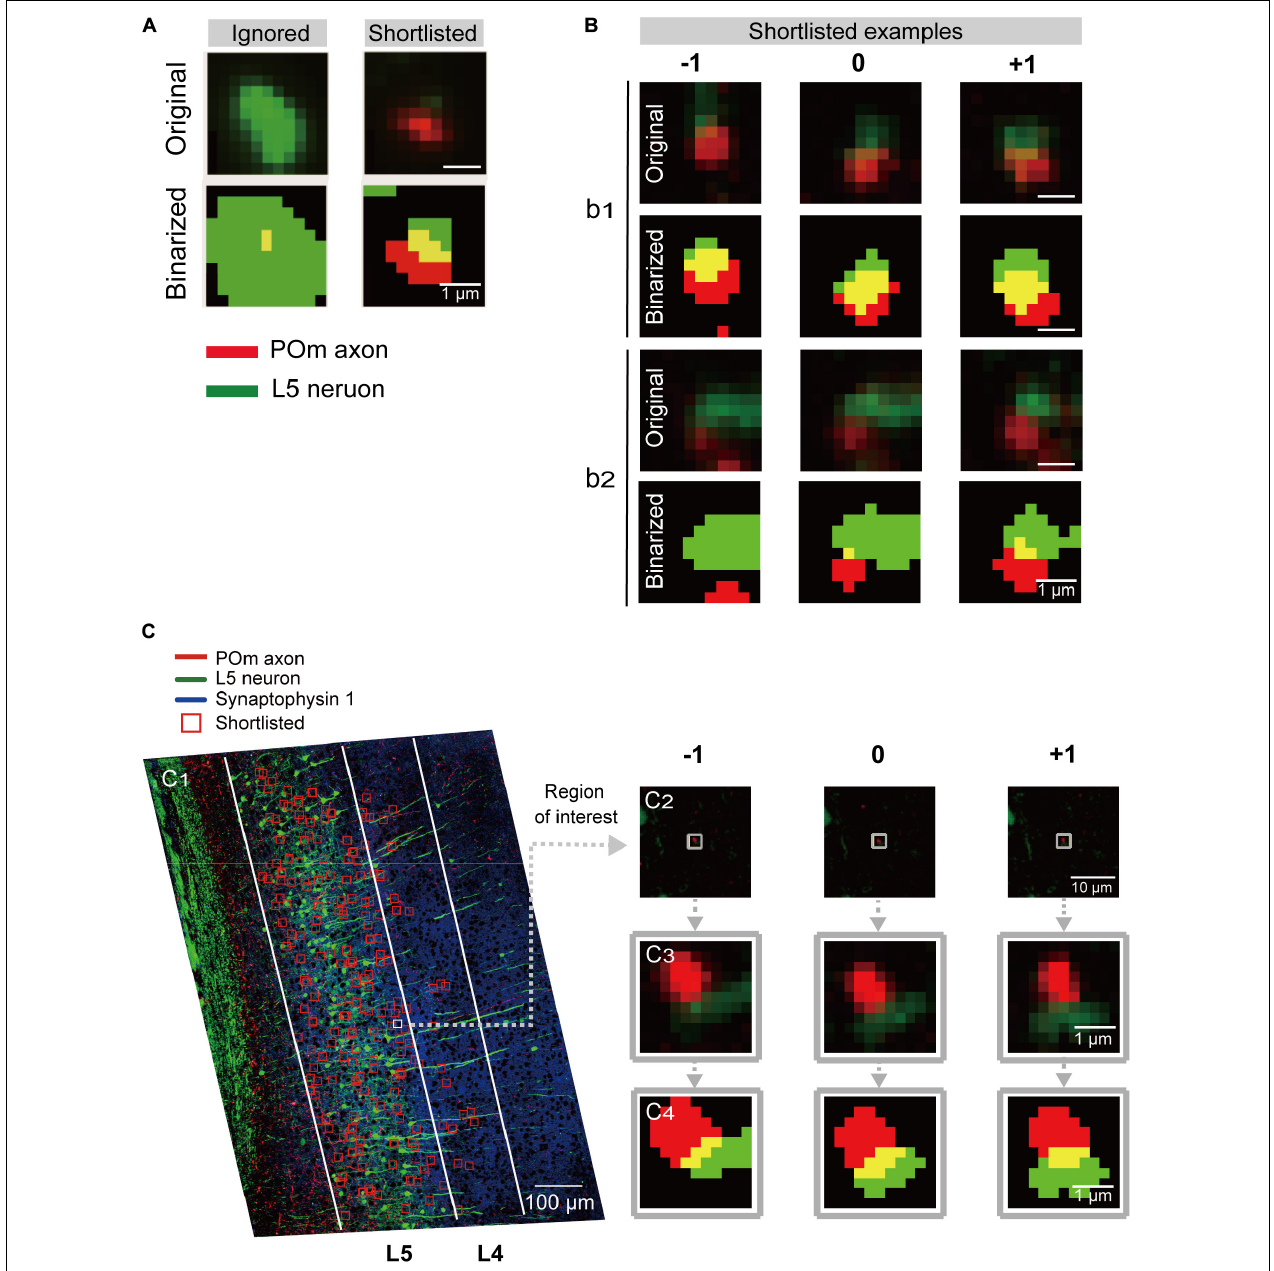
FIGURE 2 | Detection and shortlisting of synapse candidates. (A) Examples of the ROIs detected by overlapping of the binarized low-magnification images from two channels (see section “Materials and Methods” for details). ROIs without a continuous structure in the neighboring sections or ones that sat in the middle of large structures were ignored (left). Representative example of the shortlisted ROIs (right). Red and green signals were from POm axons and L5 pyramidal neurons, respectively. The overlapping region is shown in yellow. (B) Examples of shortlisted ROIs and the same coordinates of their preceding(–1) and following (+1) section. Scale bar = 1 µ m. Pixel intensity plots along the red and green lines shown in the inset images in (C) . The pixel intensities were shown along the horizontal (green) and vertical (red) lines in the conventional (dotted) and SIM (solid) images. (C 1 ) Examples of shortlisted ROIs overlaid onto the z-projected low-magnification image. The two target areas, L4 and L5, are outlined with white lines. Scale bar = 100 µ m. (C 2 ) An example of the shortlisted ROIs (middle) and the same coordinate of the preceding (left, − 1) and following (right, +1) section. Scale bar = 1 µ m. (C 3 ) Magnified images of (C 2 ) . (C 4 ) The binarized and dilated images of (C 3 ) . Scale bar = 1 µ m.